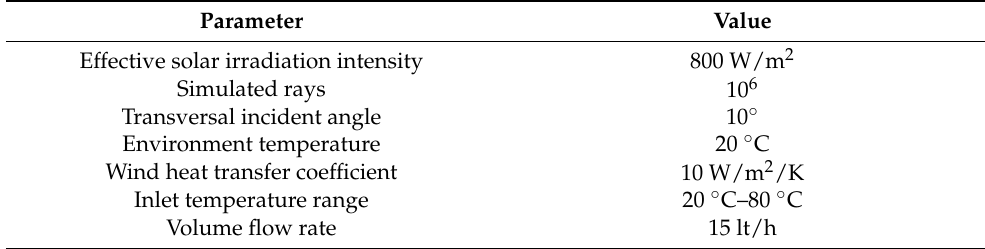
Table 5. Thermal analysis operating